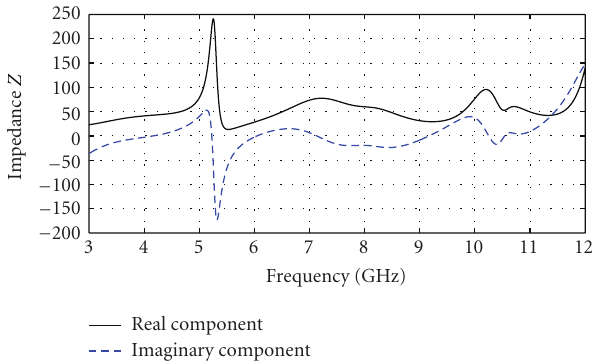
Figure 5: Impedances Z ( Ω ) versus frequency (GHz).